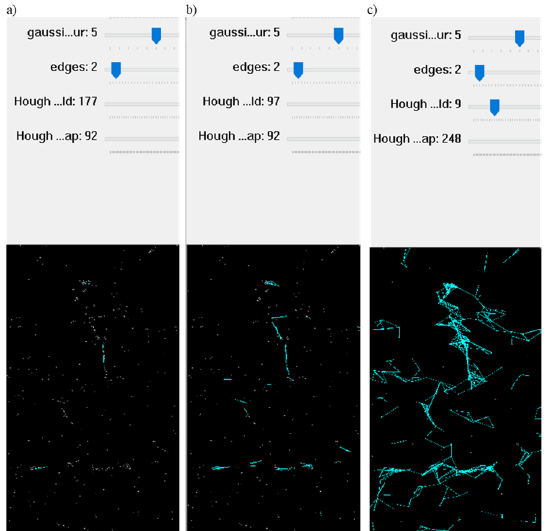
Figure 8. Sample of the interactive Hough transform program showing settings that are a) too low, b) suitable and c) too high After appropriate settings are chosen, the lines are converted from image to map coordinates and exported as georeferenced coordinate pairs. The lines can then be imported into a GIS software package for further visualisation and analysis such as bearing calculations.